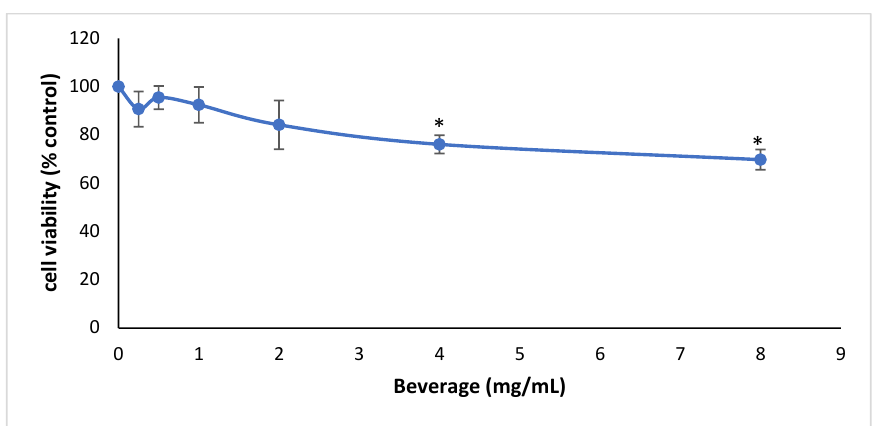
Figure 2. Cell viability following the treatment of MSC cells with the sports beverage. The results are presented as the means ± SEM of three independent experiments carried out in triplicate. * p < 0.05 indicates significant difference from the control value.